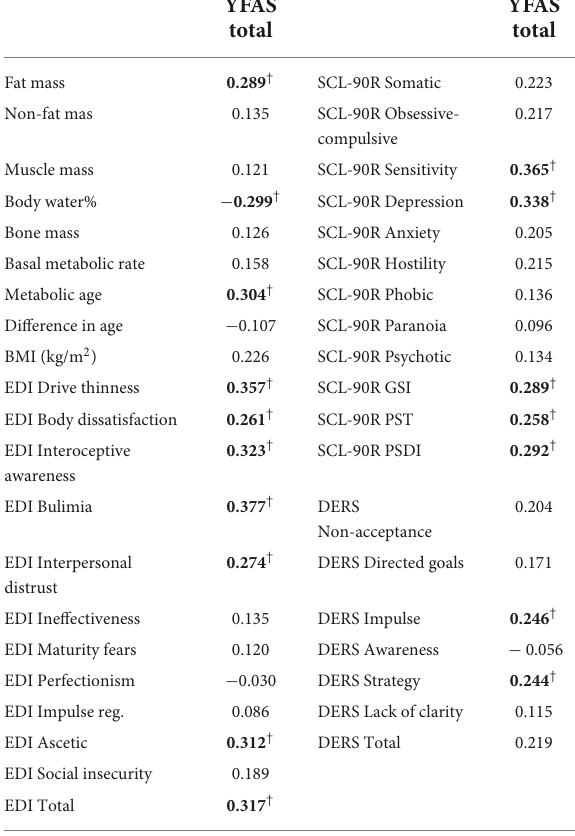
TABLE 3 Correlation